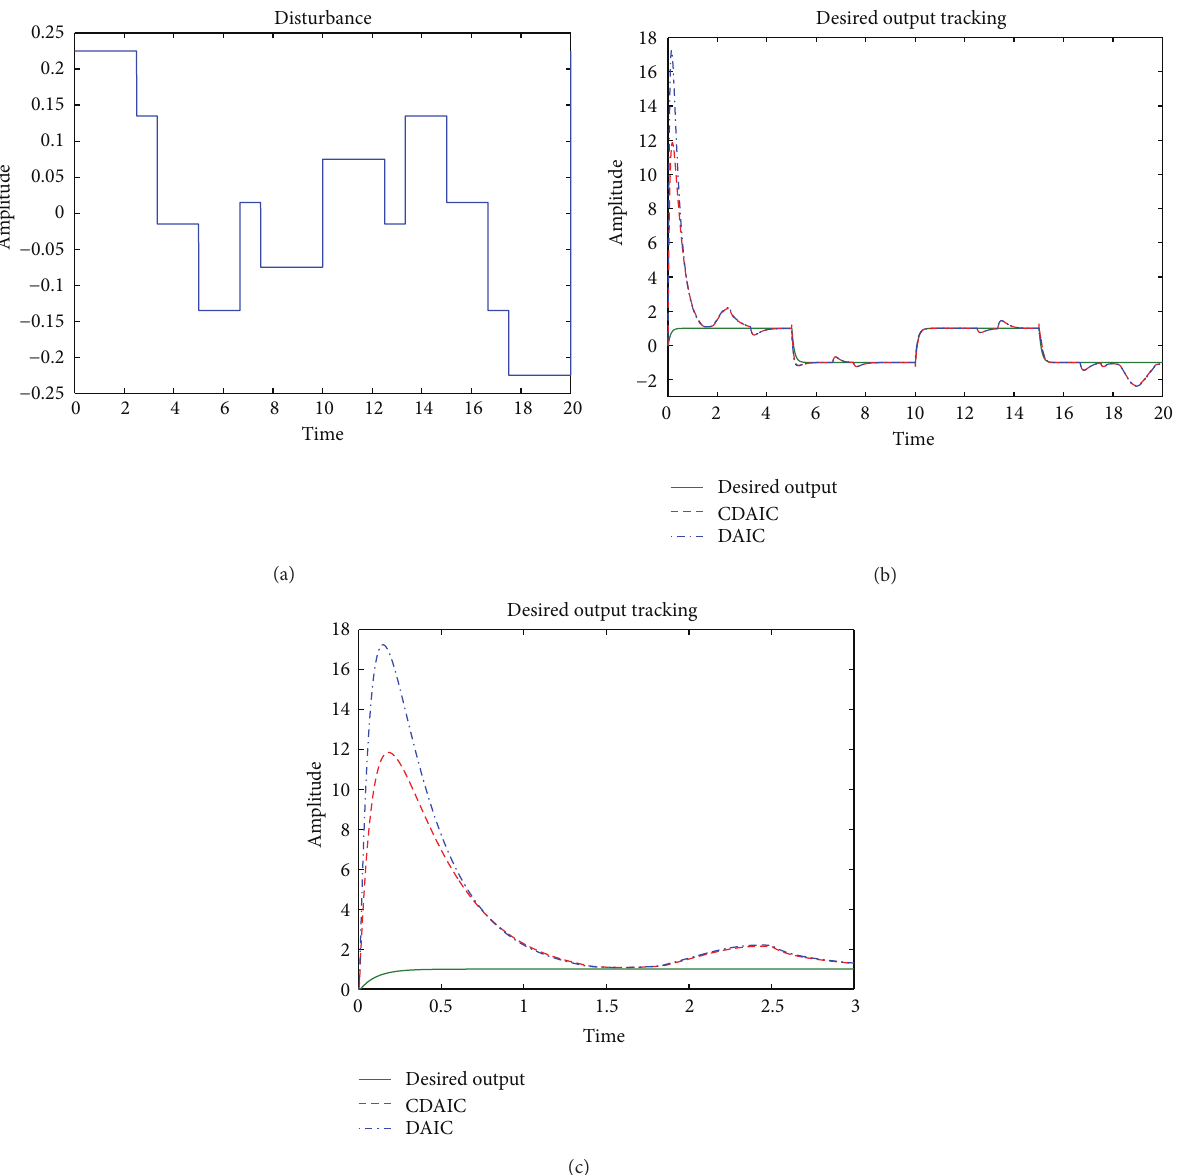
Figure 5: Example 2: simulation results: (a) disturbance; (b) tracking desired output; (c) tracking desired output (zoomed preview of first 3